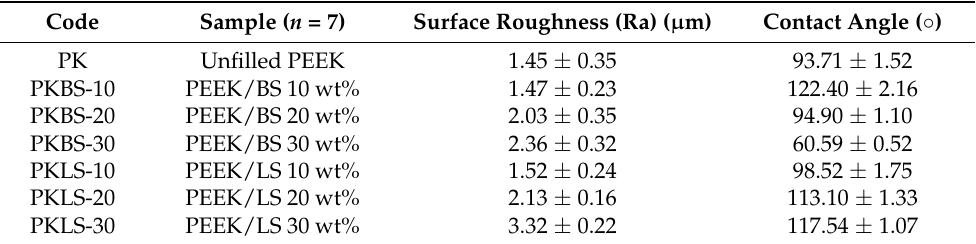
Table 2. Mean values and standard deviation (mean ± SD) for surface roughness and contact angle data of pure PEEK together with various PEEK/SiO 2